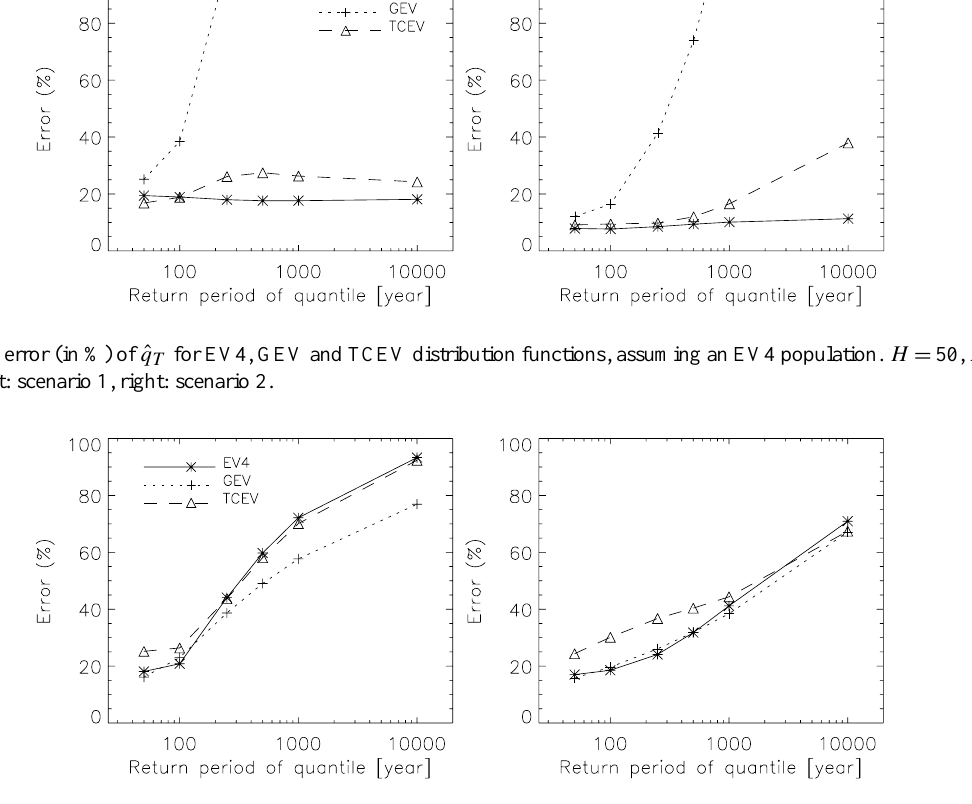
Fig. 7. Estimation error (in %) of ˆ q T for EV4, GEV and TCEV distribution functions, assuming a GEV population. H = 50, M = 400 and N = 50 years. Left: scenario 1, right: scenario 2.